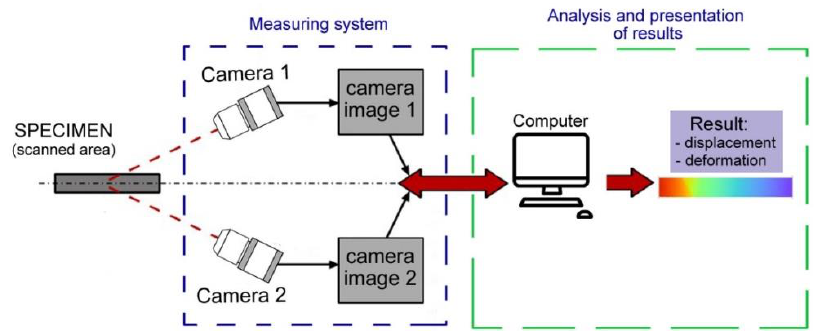
Figure 4. Diagram of deformation measuring system.